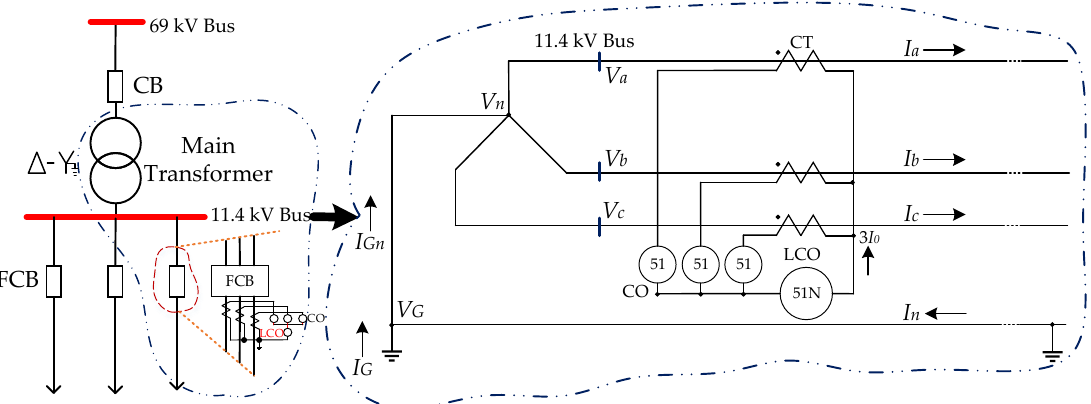
Figure 11. The single line diagram of LCO protective relay in the three-phase, four-wire distribution systems.